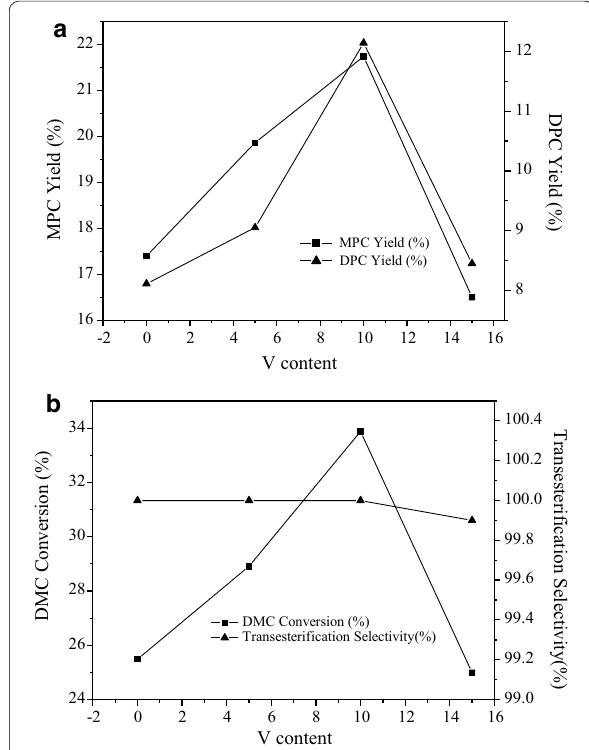
Fig. 9 a The influence of V content on the catalytic activity; b